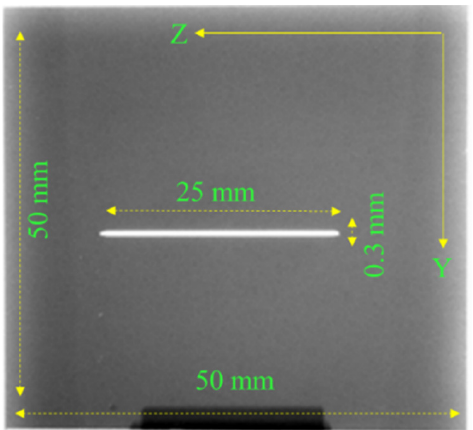
Figure 3. CT results of a stainless-steel